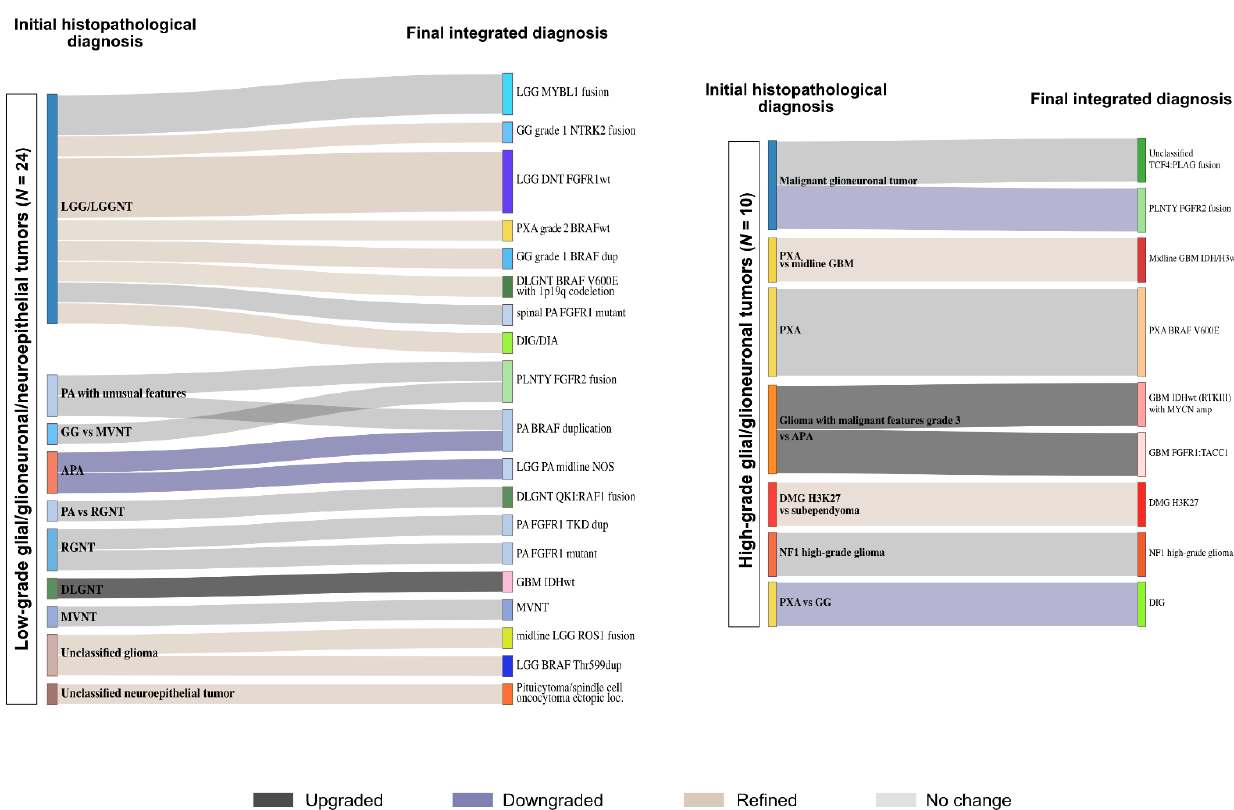
Figure 6. Establishing diagnoses in glial tumors. The integration of data from DNA methylation array to the initial histopathological diagnosis (left) helped establishing final diagnoses (right) in low-grade glial/glioneuronal tumors (left panel) and high-grade glial/glioneuronal tumors (right panel). WHO grading changes are indicated in dark grey (upgrading), blue (downgrading) and light brown (refined). LGG = low-grade glioma, LGGNT = low-grade glio-neuronal tumor, PA = pilocytic astrocytoma, GG = ganglioglioma, MVNT = multinodular and vacuolating neuronal tumor, APA = pilocytic astrocytoma with anaplastic features, RGNT = rosette forming glioneuronal tumor, DLGNT = diffuse leptomeningeal glioneuronal tumor, PXA = pleomorphic xanthoastrocytoma, DIG/DIA = desmoplastic infantile ganglioglioma/astrocytoma, PLNTY = polymorphous low-grade neuroepithelial tumor of the young, GBM = glioblastoma, DMG = diffuse midline glioma.